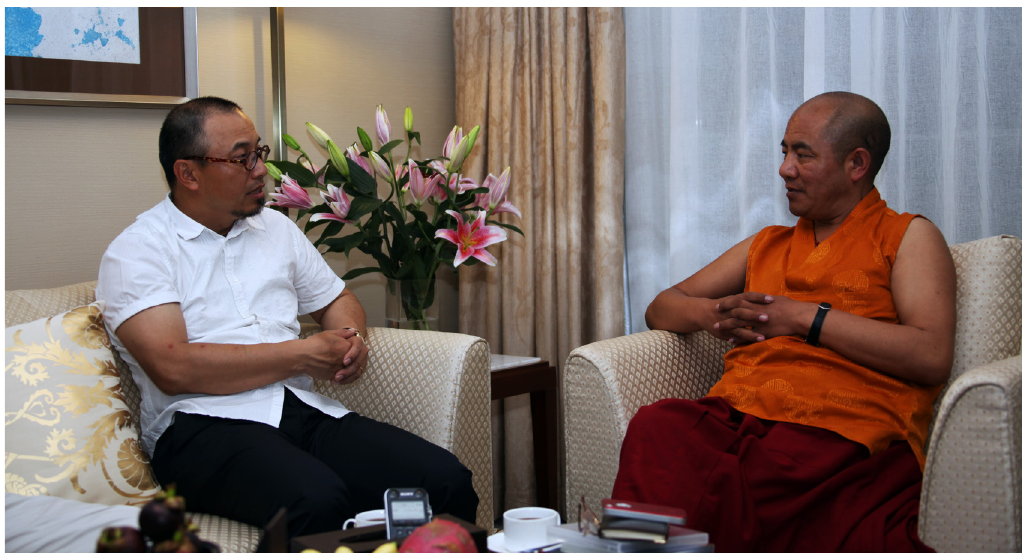
Figure 2. The co-authors working together, summer 2012. Photo by Yang